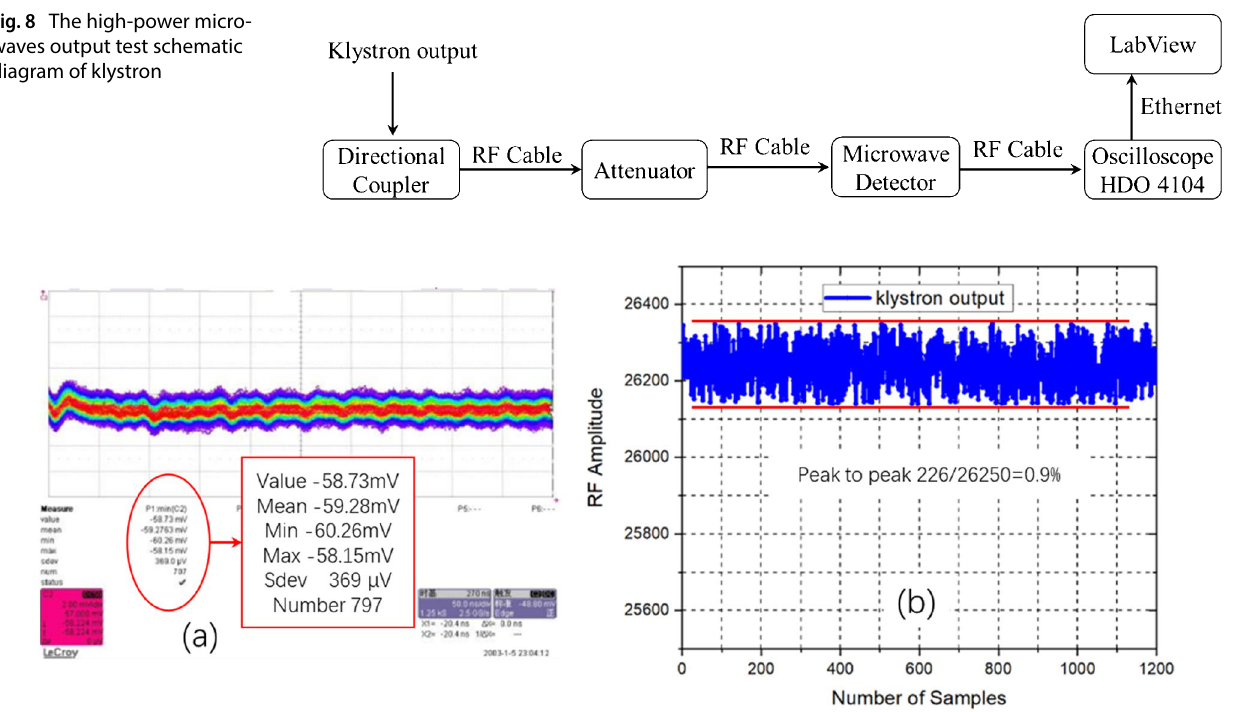
deviation of 1200 consecutive pulses measured with data acquisi- tion system based on ADC